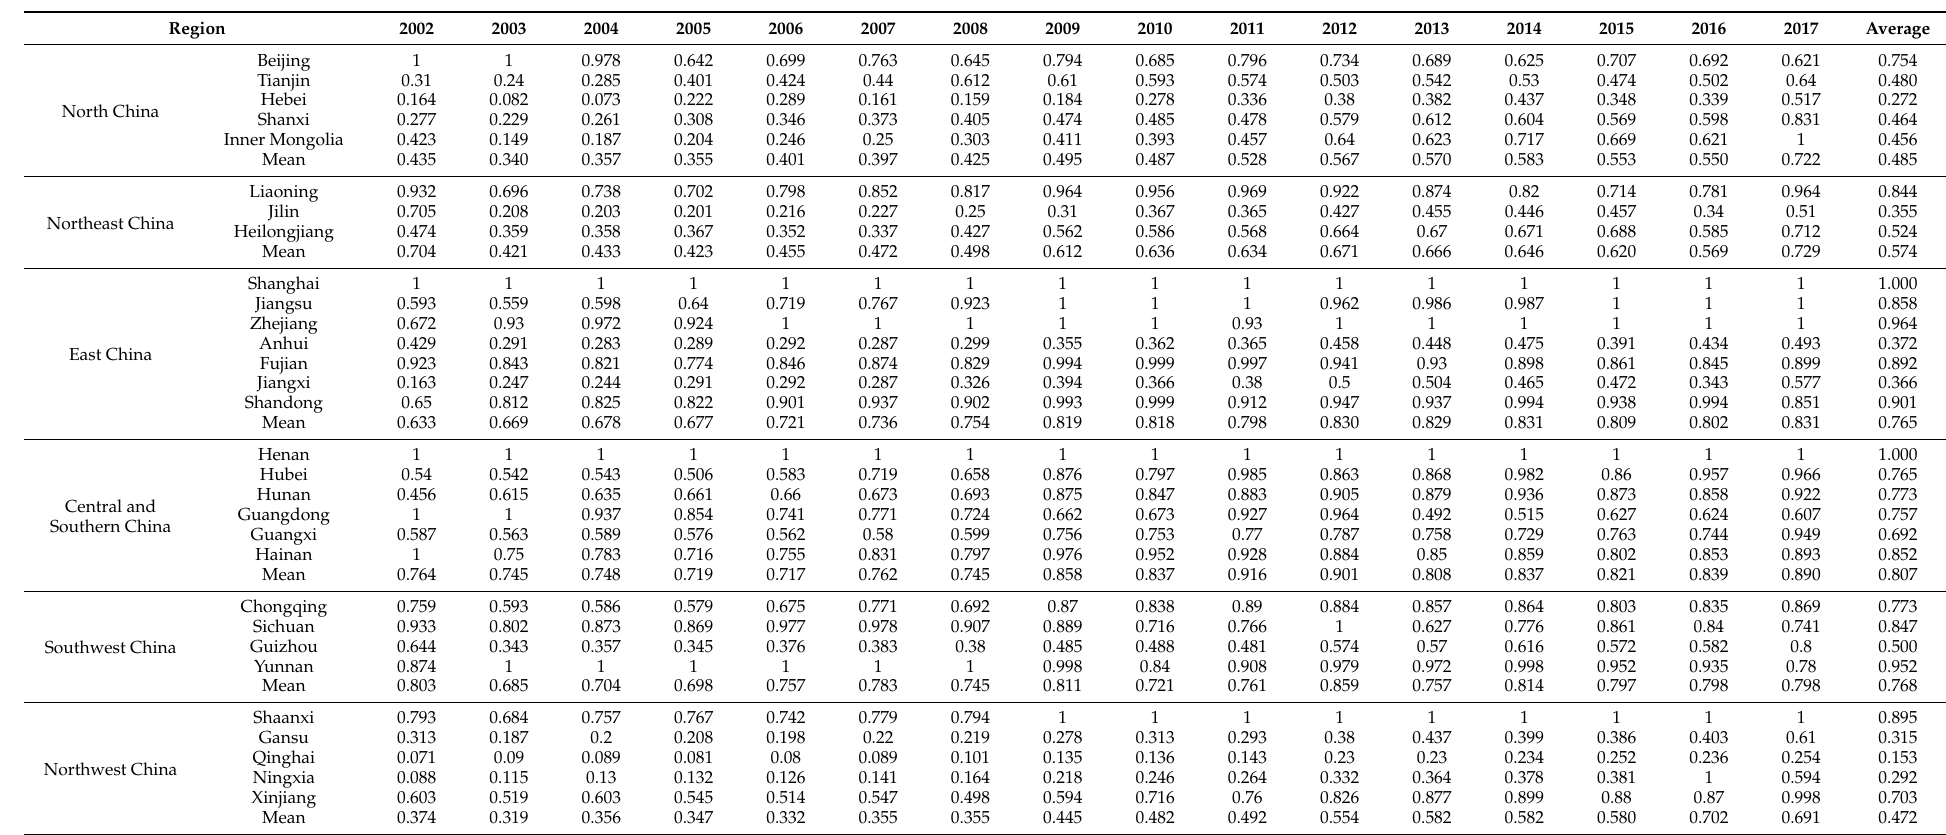
Table 4. The third stage scale efficiency (SE)